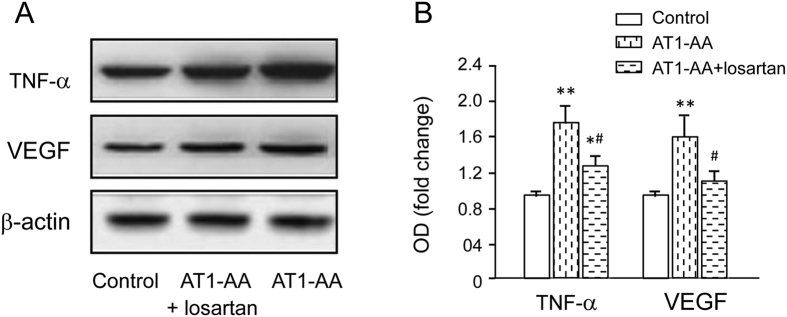
The effect of AT1-AA on retinal level of VEGF and TNF-α expression in the rat retina 10 days after injection.(A) Retinal levels of VEGF, TNF-α and β-actin were measured by Western blot. (B) The expression levels of VEGF and TNF-α were quantified by densitometry, normalized to β-actin levels, and expressed as percentages of the respective control values. Values are mean ± SD. *p < 0.05, **p < 0.01 vs. Group N; #P < 0.05, ##P < 0.05 vs. Group A, respectively.